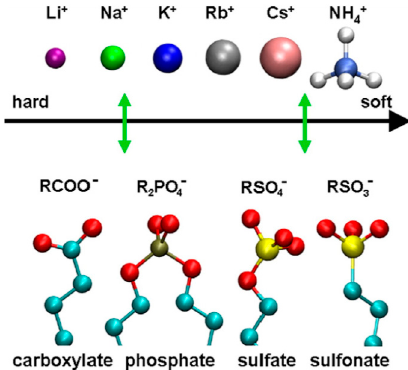
Figure 2. Affinity ordering of anionic surfactant headgroups and the respective counterions. Reprinted from [33] with permission, Copyright Elsevier, 2009.